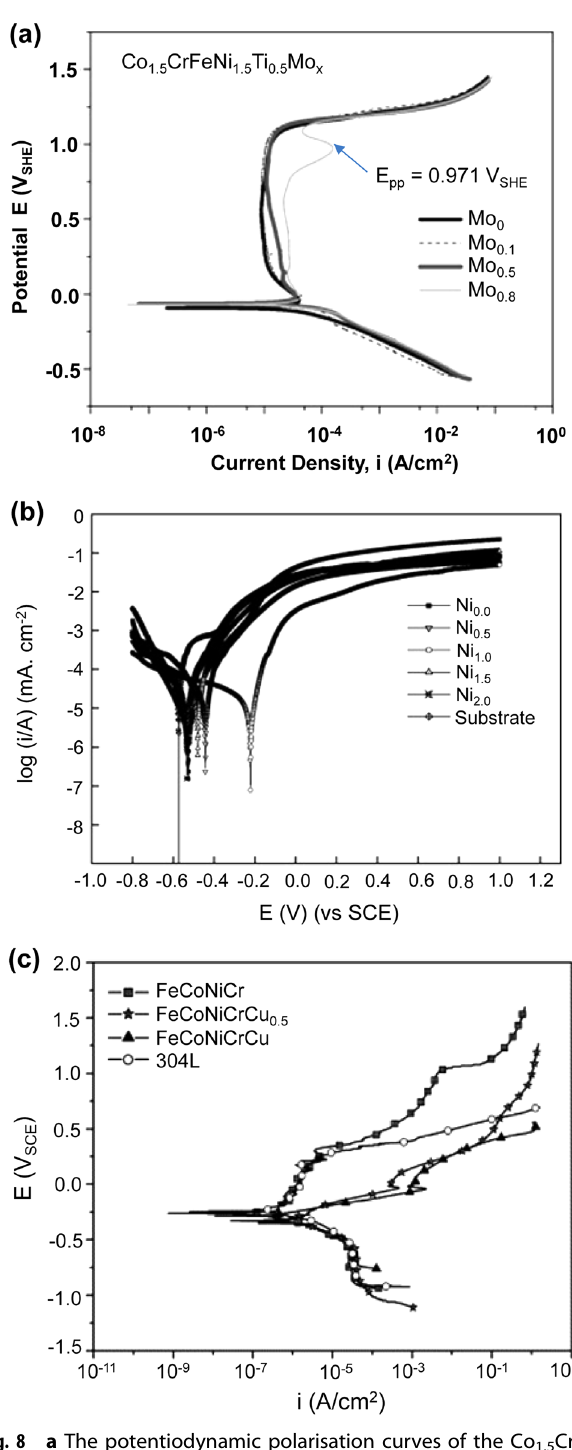
Fig. 8 a The potentiodynamic polarisation curves of the Co 1.5 CrFe- Ni